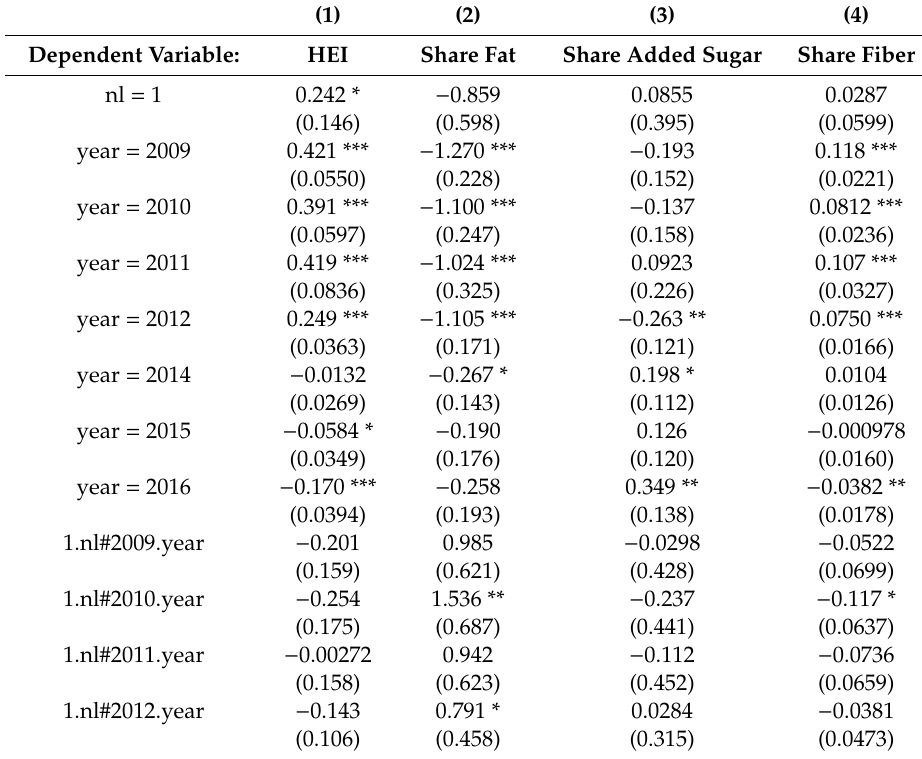
Figure A1. Average HEI and nutrient composition from 2009 to 2016 for NL switchers (black) and extended control group (grey). Note: The vertical lines indicate the years in which the questionnaires were sent to the panel. The average is based on households that answered both questions on label use in 2013 and 2015. The averages are based on an unbalanced panel from 2009 to 2016, as not all of the household stay in the panel from 2009 to 2016. Table A5. Test of common trend of NL switchers and extended control